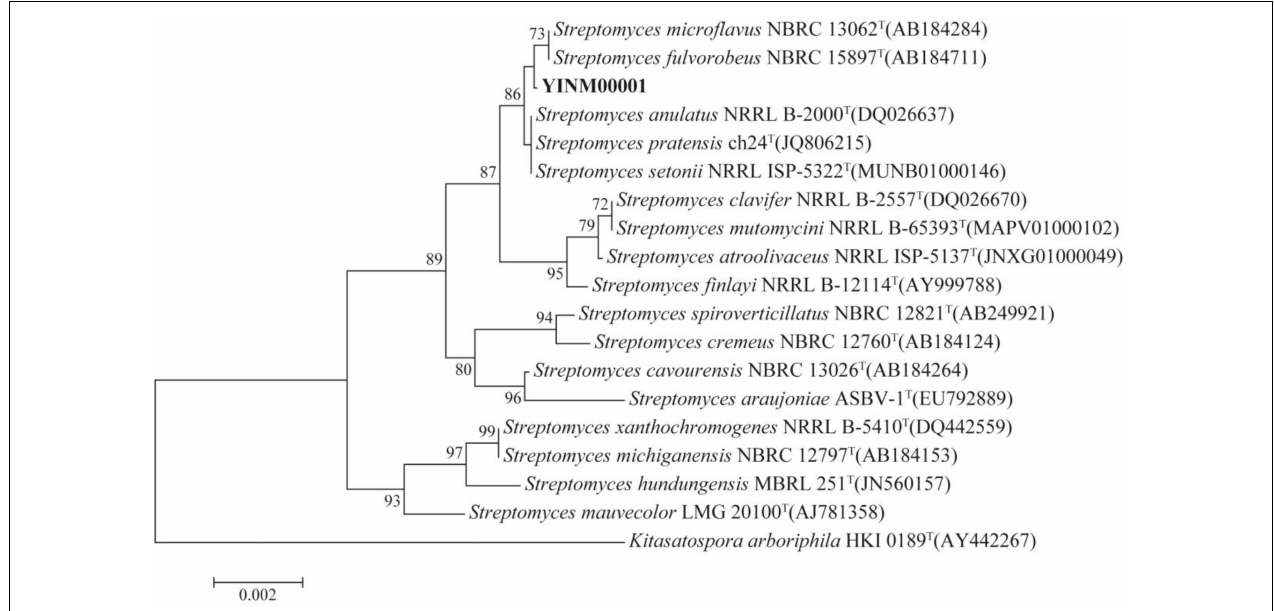
FIGURE 2 | The neighbor-joining phylogenetic tree of strain YINM00001 and its closest relatives from the genus Streptomyces based on 16S rRNA genes. Bootstrap values ( > 70%) based on 1,000 resamplings are given at the nodes. Kitasatospora arboriphila NRRL HKI 0189T (accession no. AY442267) was used as outgroup. Bar, 0.002 substitutions per nucleotide